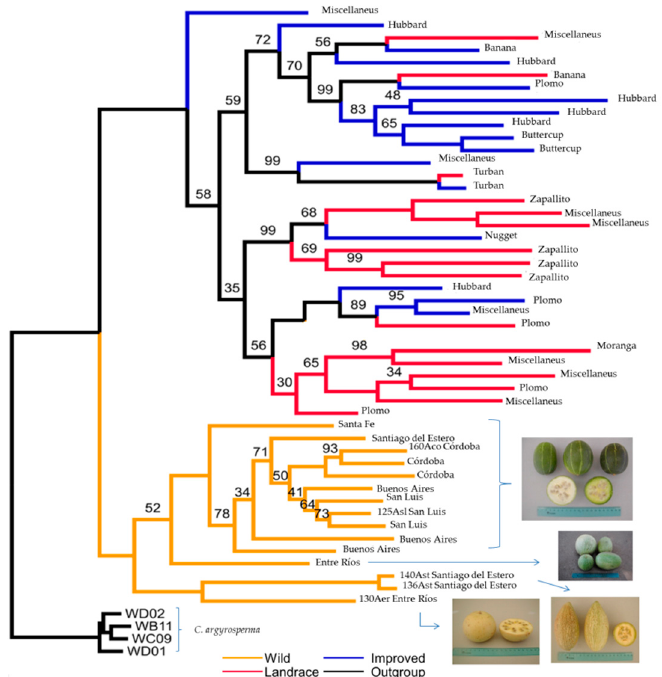
Figure 17. Phylogenetic tree of C. maxima adapted from [40]. In the domesticated clade, entries are assigned to cultivar-groups according to external fruits characteristics, otherwise indicated as miscellaneous. In the wild ssp. andreana clade, Argentinian provinces of provenances are given, and for those included in [59], the original tripartite code is also indicated.